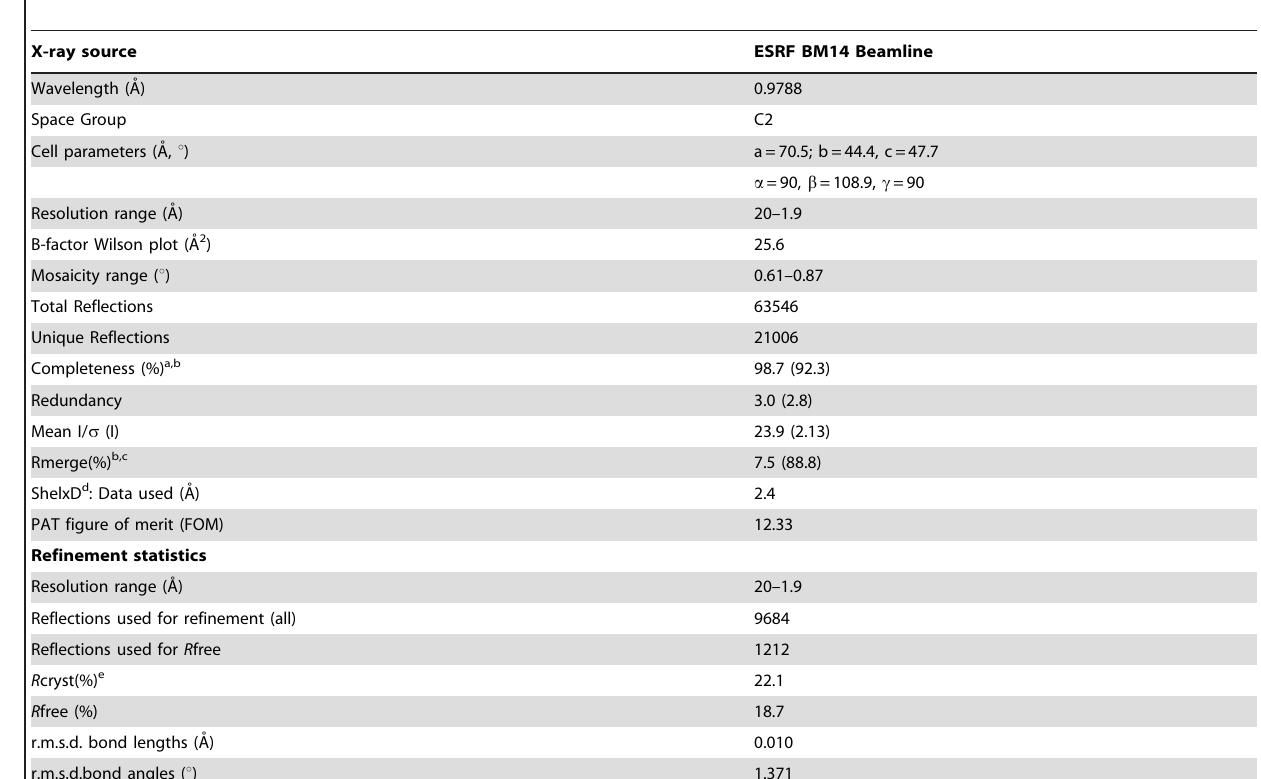
Table 1. Crystallographic data-collection